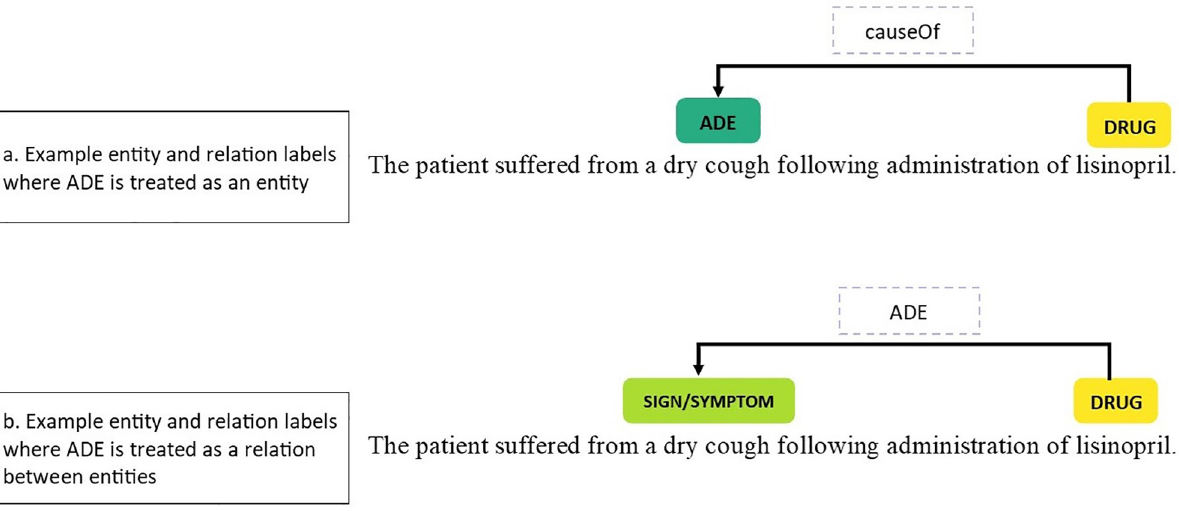
Fig 5. Definition of an ADE as an entity or as a relation in the text; solid coloured rectangles represent entities and dashed line boxes over linking arrows represent relationships between entities.